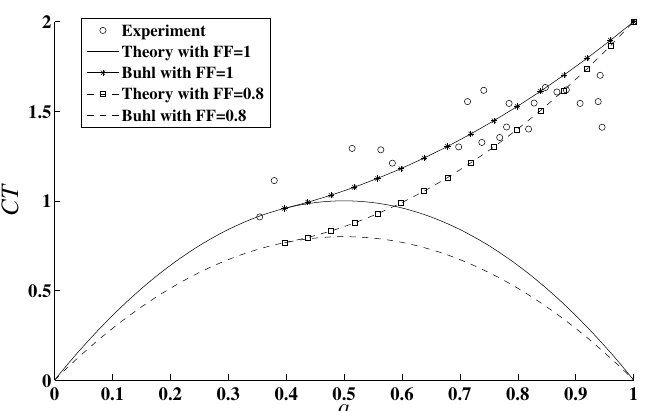
Figure 10. The fitting proposed by Buhl [19], shown without tip-hub losses, FF = 1, and with a tip-hub loss factor FF = 0.8.